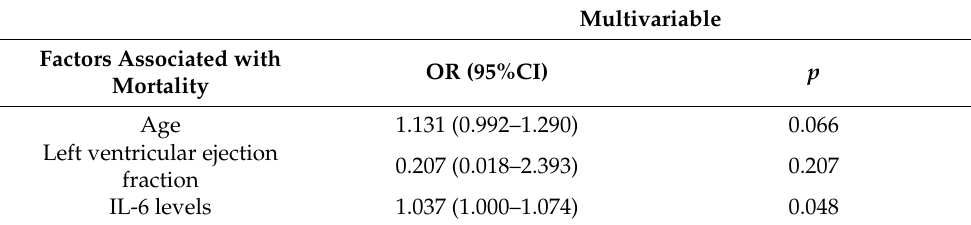
Table 3. Logistic regression analysis of factors associated to mortality.